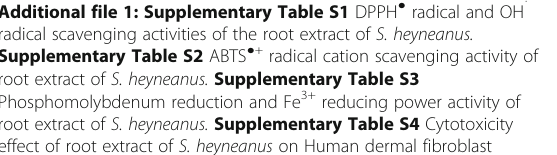
Supplementary Table S2 ABTS ● + radical cation scavenging activity of root extract of S. heyneanus. Supplementary Table S3 Phosphomolybdenum reduction and Fe 3+ reducing power activity of root extract of S. heyneanus. Supplementary Table S4 Cytotoxicity effect of root extract of S. heyneanus on Human dermal